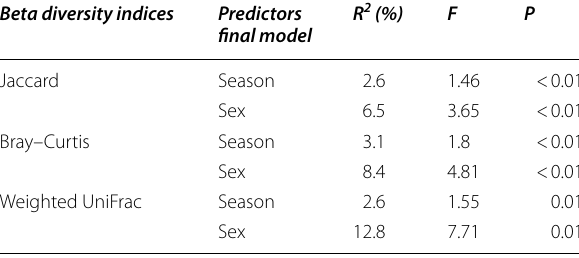
a Only the final models are presented. Units of the factors: season, summer and winter; sex, female and